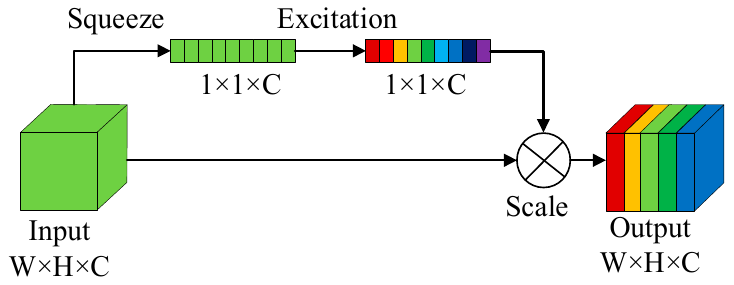
Figure 5. The structure of the squeeze-and-excitation (SE) network.